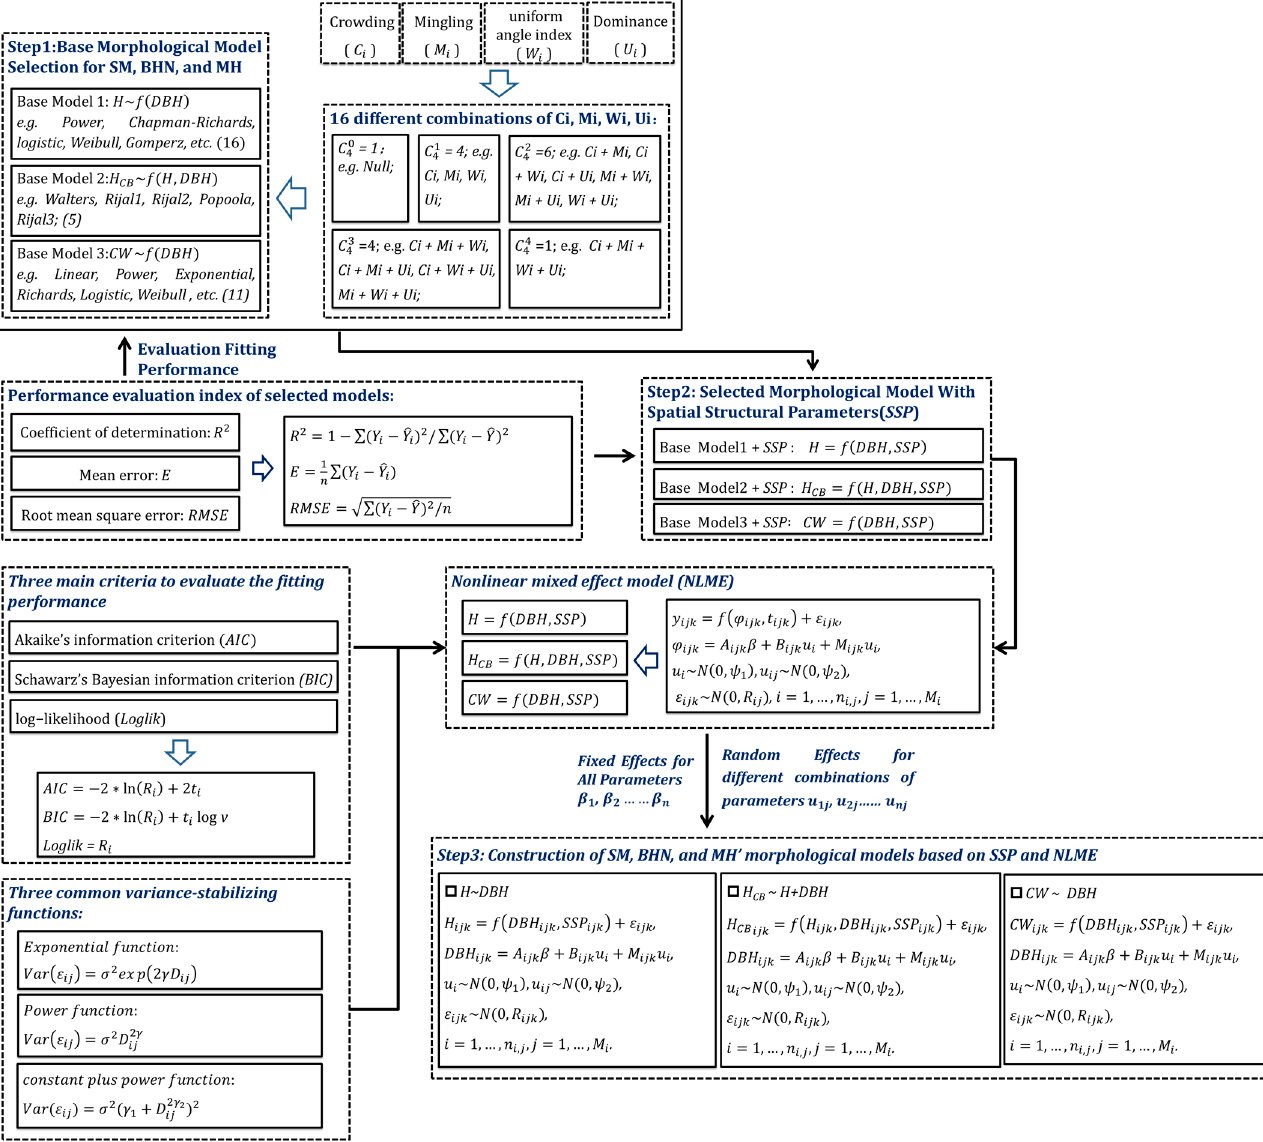
Figure 3. Schematic diagram showing the nonlinear mixed-effect morphological model with spatial-structure parameters (SSP). It includes three steps of morphological construction based on SSP and NLME, evaluation index, and variance-stabilizing functions. The first step is the selection of the base morphological models of SM, BHN, and MH; the second step is the selection of the morphological model with spatial-structure parameters ( SSP ); and the third step is the construction of the nonlinear mixed-effect of SM, BHN, and MH. SM, BHN, and MH represent Cunninghamia lanceolata , Machilus pauhoi, and Schima superba, respectively. Table 2. Base model selection: H is the total tree height (m), DBH is the diameter at breast height (cm), H CB is the height-to-crown base (m), and CW is the crown width (m); a, b, and c are the parameters of the model. M1~M32 represents the formulae of the morphological characteristic models.